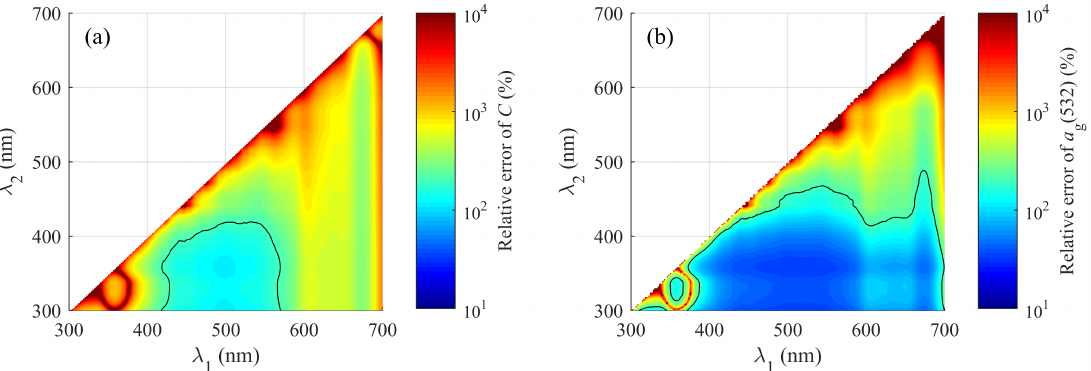
Figure 3. Dual-wavelength inversion error under Case 1 in Table 1 of ( a ) C and ( b ) a g (532). The black line indicates that the inversion error is 200%.